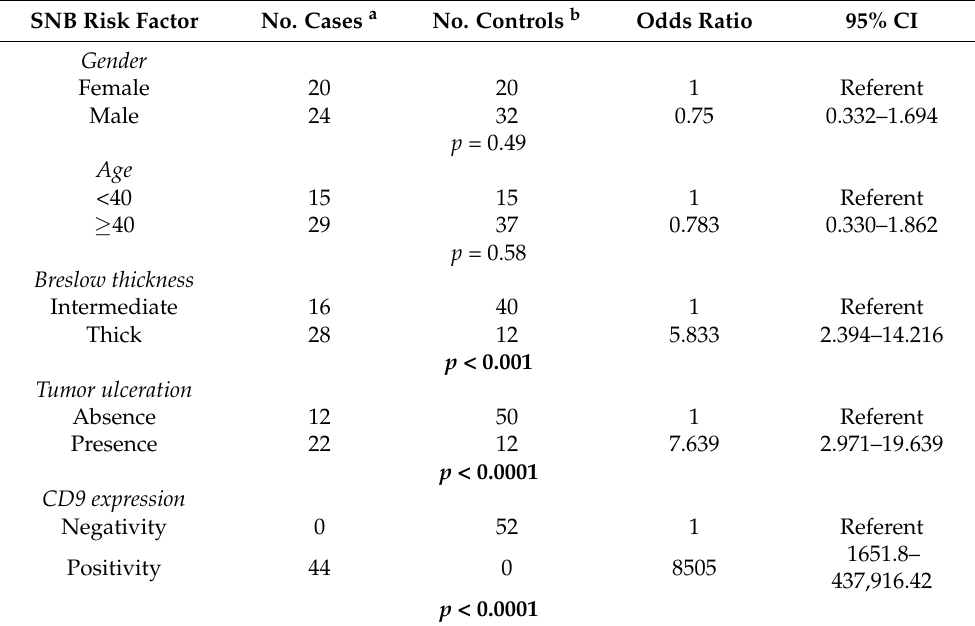
Table 2. Predictive values of high-risk pathological and clinical features for positive sentinel lymph node biopsy (SNB) in patients with intermediate and thick melanomas.